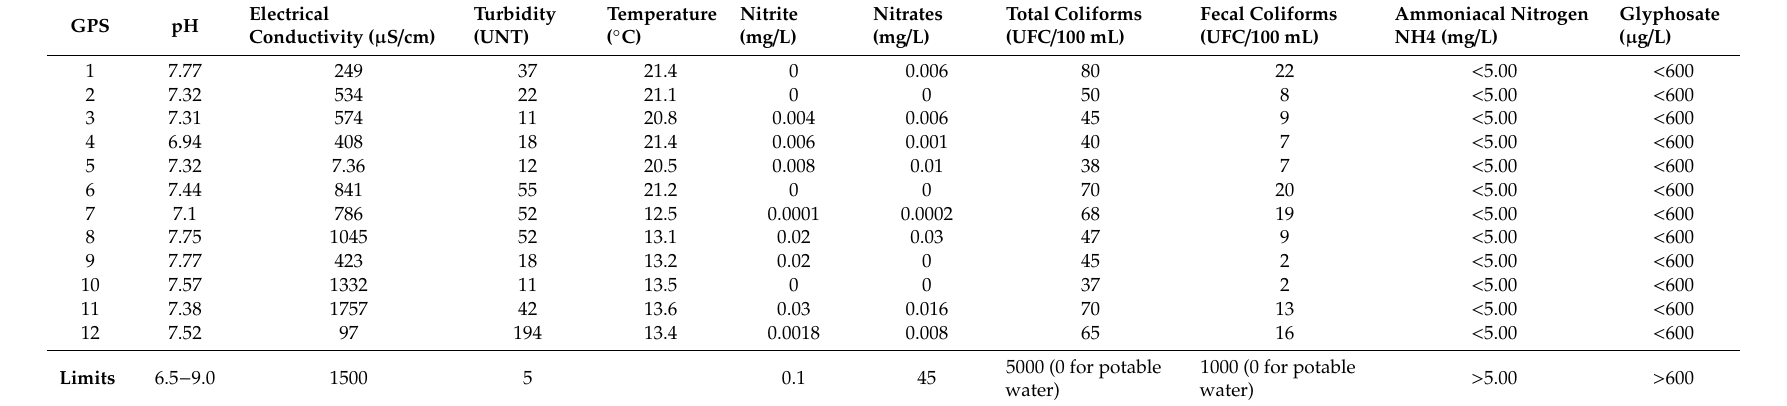
Table 16. Results of the microbiological and chemical water